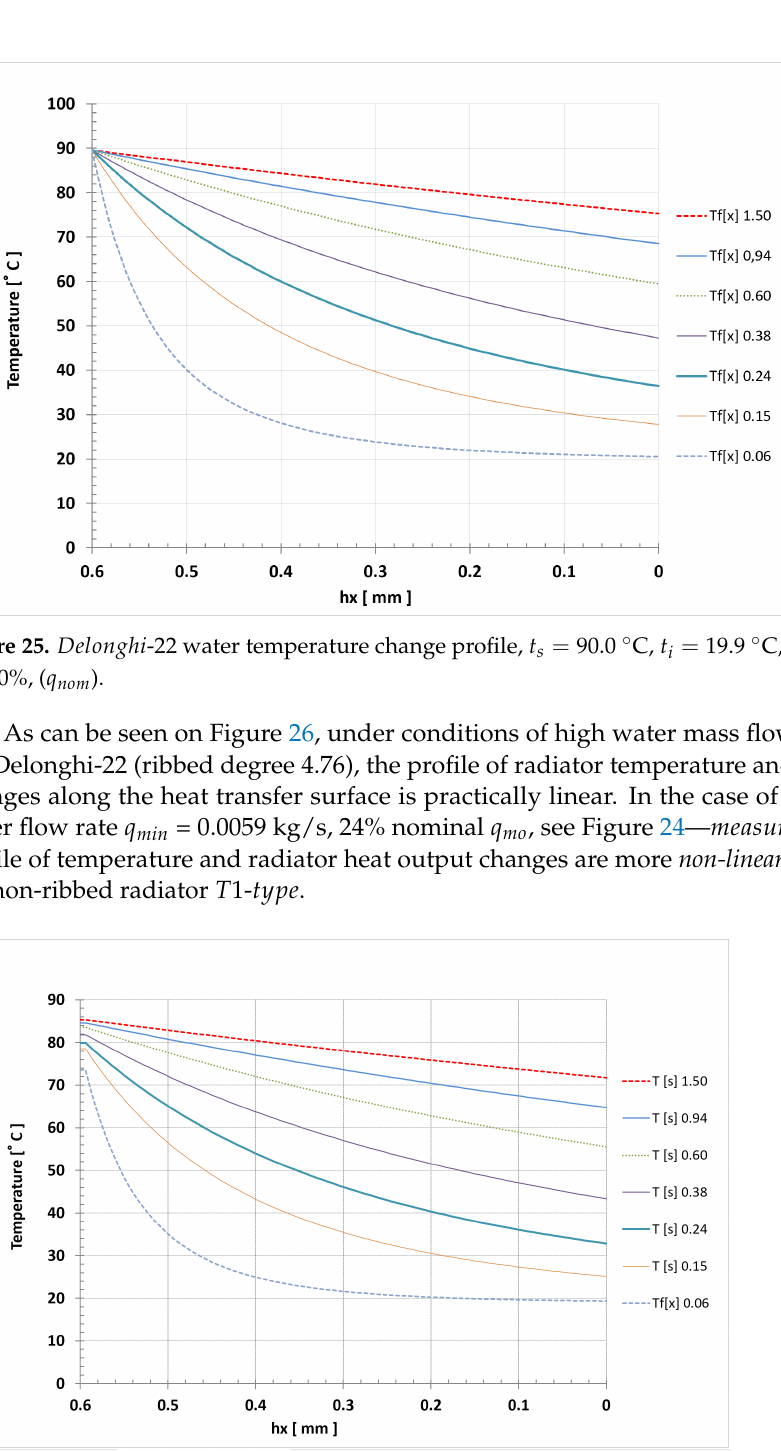
Figure 26. Delonghi -22 surface temperature change profile, t s = 90.0 ◦ C, t i = 19.9 ◦ C, q mx from 6.0% to 150%, ( q nom